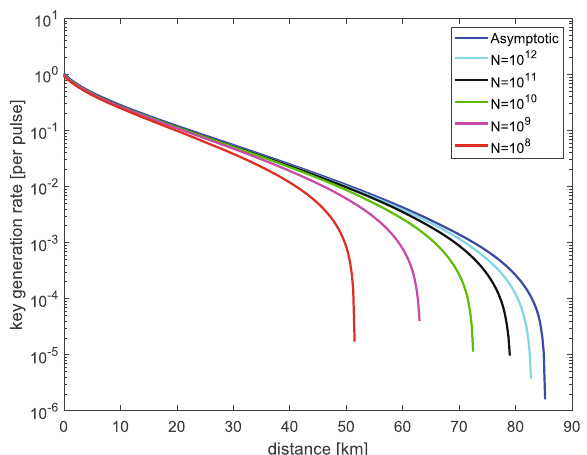
Fig. 9 The secret key rate with fi nite-size effects. Here, we compute the secret key rate vs distance with fi nite-size effects. Numerically optimized secret key rates are obtained for a fi xed block size N = 10 s with s = 8, 9, 10, 11, and 12. The rightmost curve corresponds to the asymptotic secret key rate. Here, we consider the Gaussian distribution model with variance 10 − 4 . The failure probability of parameter estimation is ϵ PE = 10 − 10 . The failure probability of untagged Gaussian states is ϵ ugs = 10 − 10 . The failure probability of privacy ampli fi cation is ϵ PA = 10 − 10